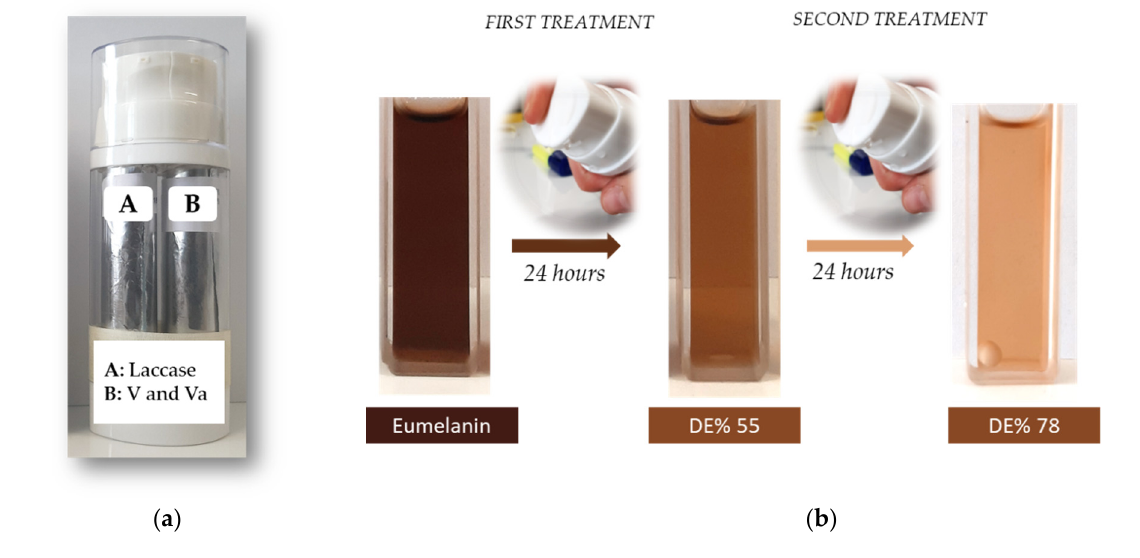
Figure 4. Panel ( a ): selected 6X formulation. Panel ( b ): application of the whitening cream 6X.